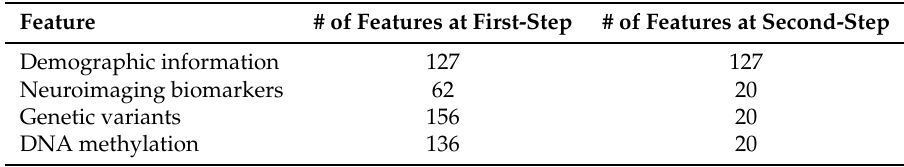
Table 2. Statistics of feature selection data.